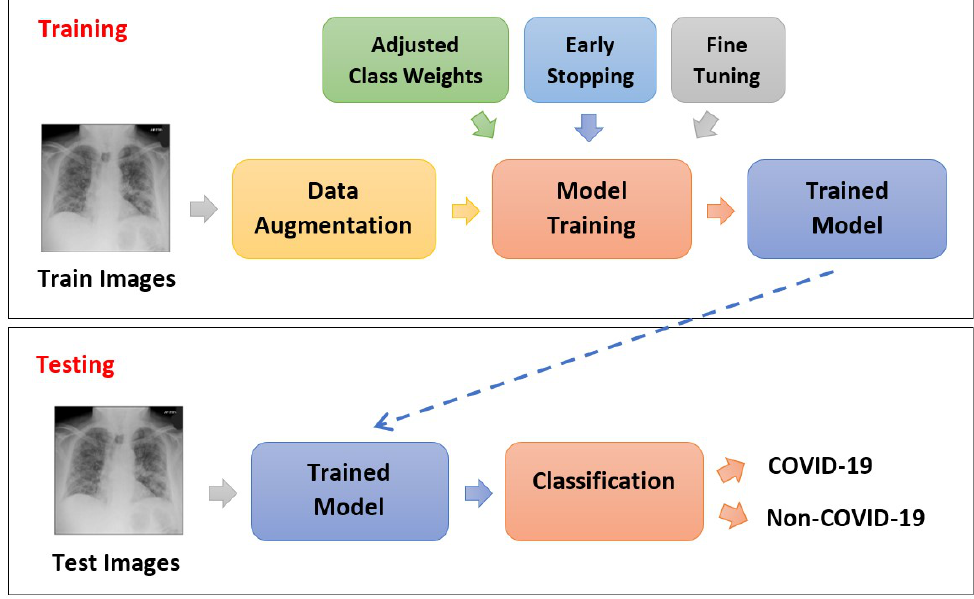
Figure 8. The process flow of the proposed COVID-19 diagnosis with enhanced